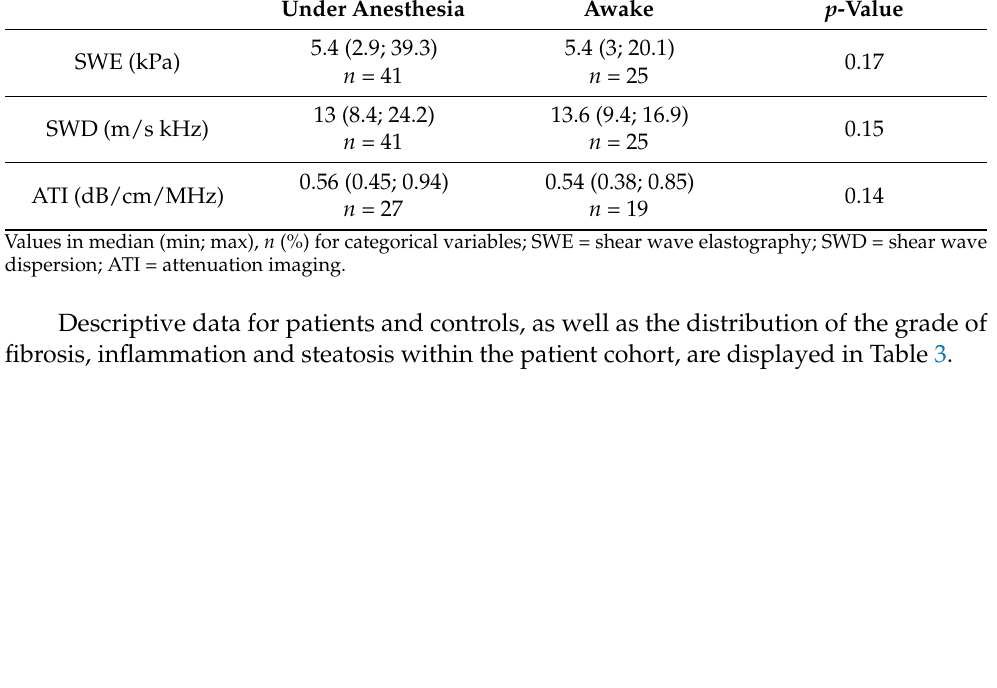
Table 2. Distribution of obtained ultrasound-based markers in anesthetized and awake patients. Under Anesthesia Awake p -Value 5.4 (2.9; 39.3) SWE (kPa) n = 41 13 (8.4; 24.2) 13.6 (9.4; 16.9) SWD (m/s kHz) n = 41 n = 25 0.56 (0.45; ATI (dB/cm/MHz)